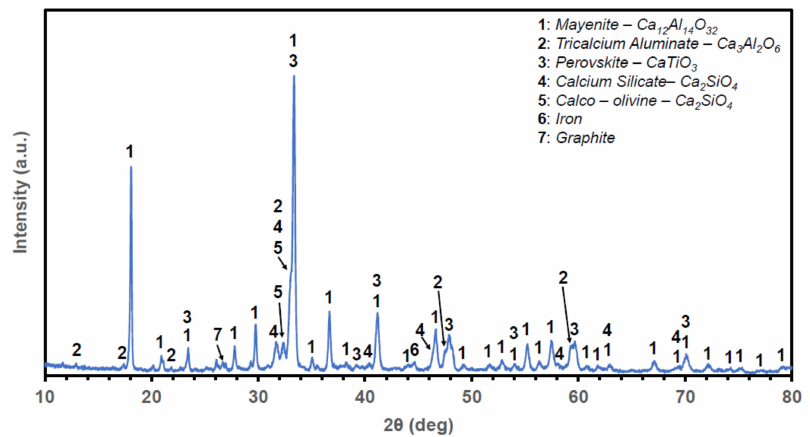
Figure 3. Powder X-ray Diffractogram and phase identification of the Ca-rich slag used for the laboratory scale experiments of this